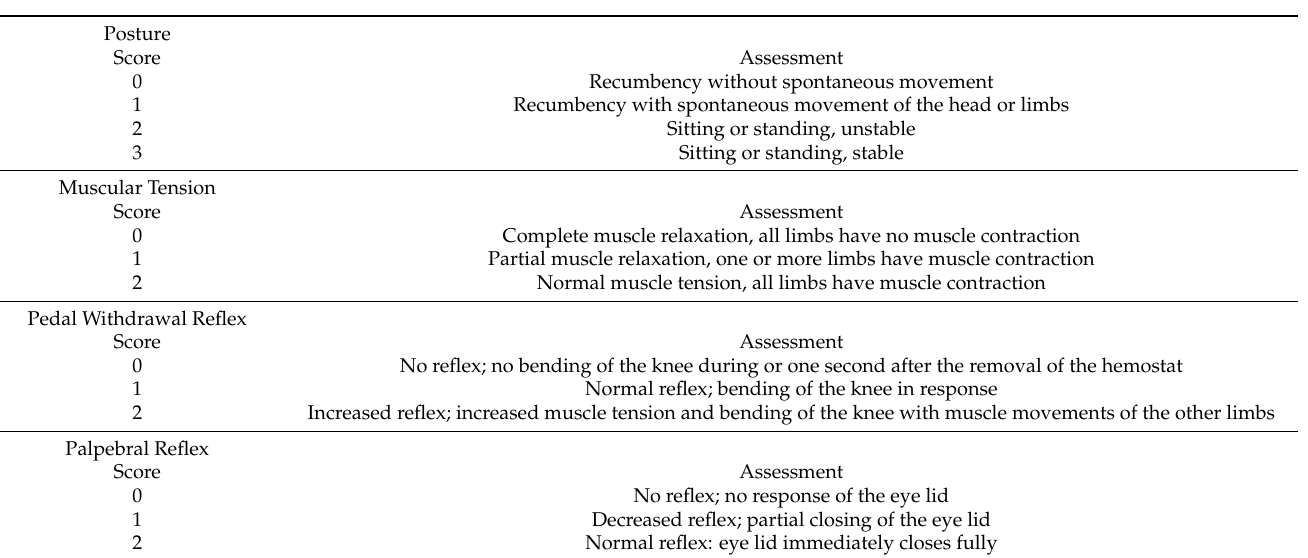
Table 1. Objective scoring system for each assessment to determine the depth of the sedation or anesthesia.